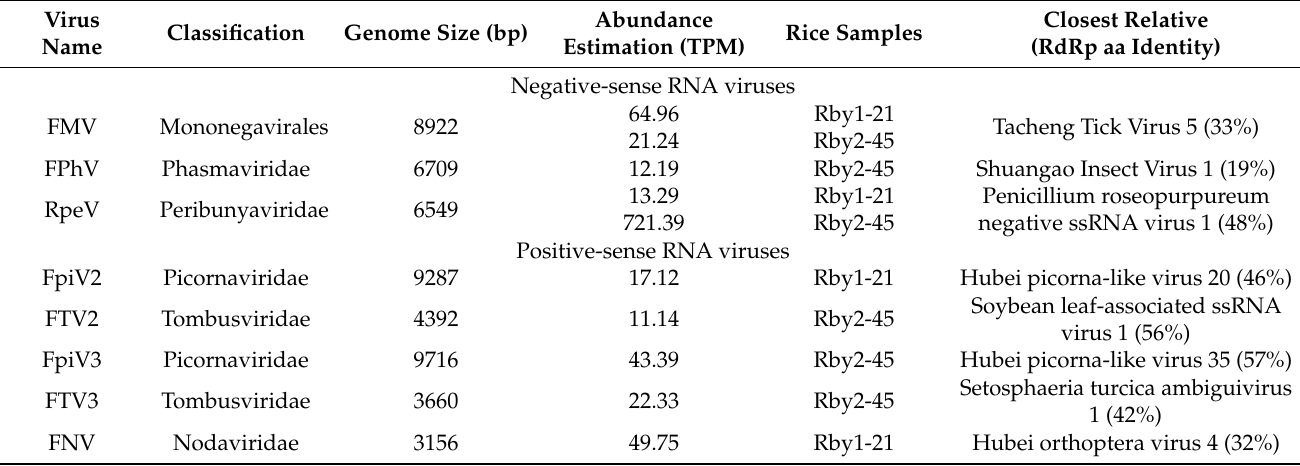
Figure 2. Genome structures of novel viruses. Predicted viral proteins homologous to known viral proteins are shown according to their putative functions. Table 1. Classifications, genome characteristics, and abundance of the novel